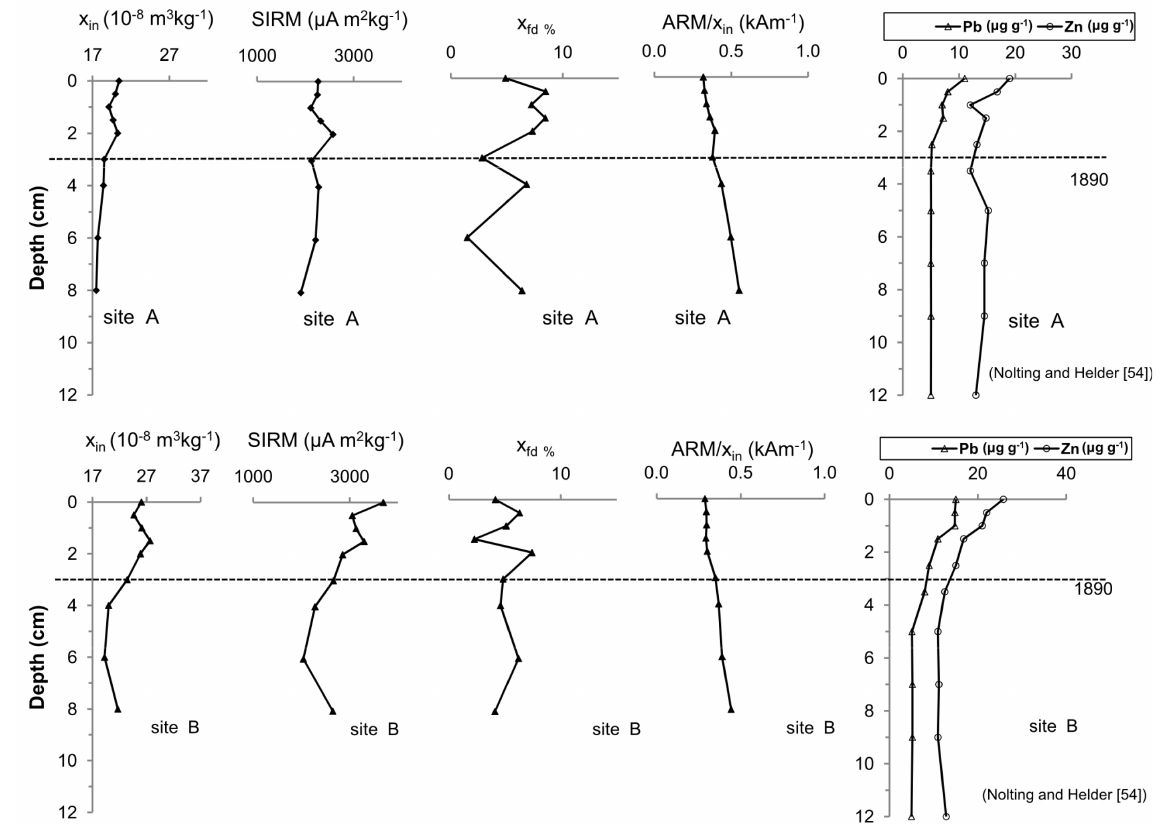
Figure 6. Vertical distribution of χ (10 − 8 m 3 ·kg − 1 ), SIRM ( μA ·m 2 ·kg − 1 ) and χ in and B. The profiles of Pb and Zn concentration are shown for the same sites (adapted from Nolting and Helder [54]). Horizontal line shows the horizon of surface sediment about 100 years